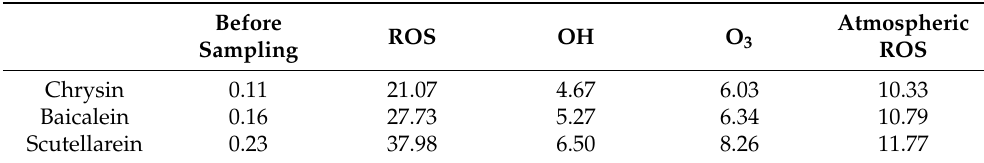
Table 3. Fluorescence increase (%) before and after membrane reaction of active molecules of baicalein, baicalein, and wild baicalein.